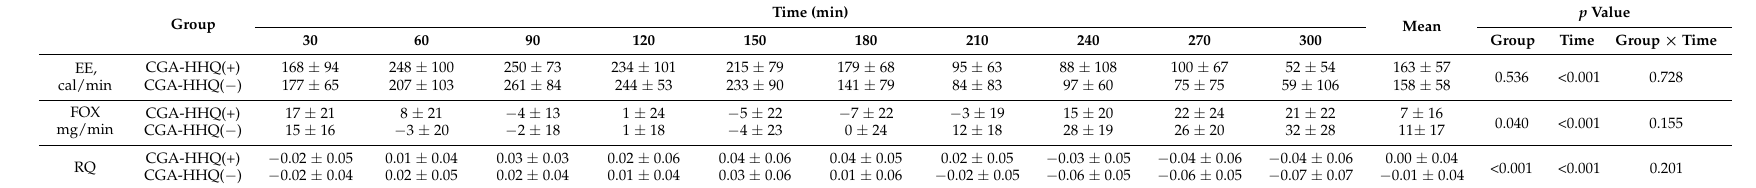
Table 4. Changes in EE, FOX, and RQ up to 300 min after the test meal following the four-week